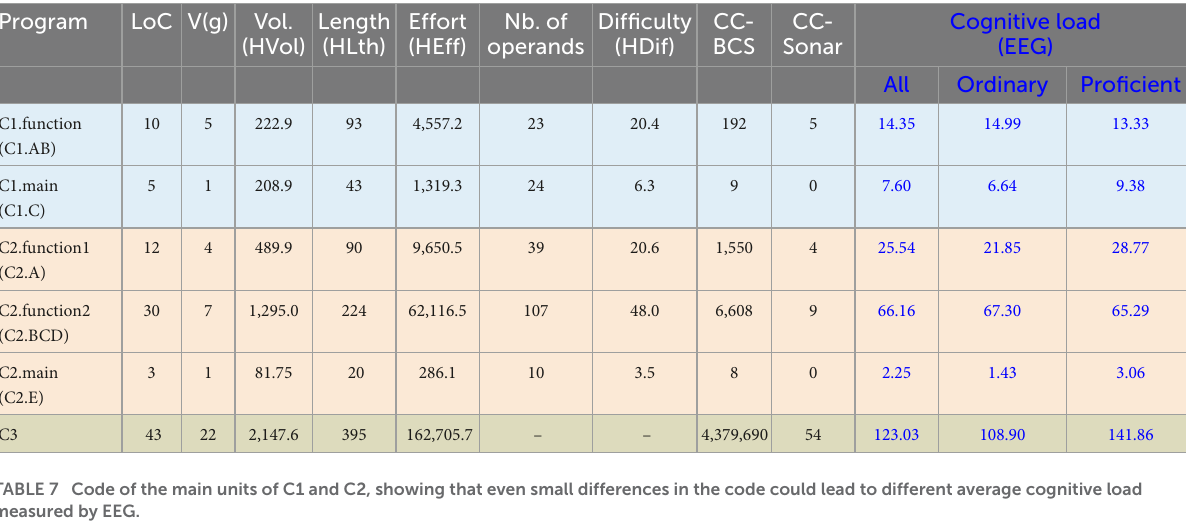
TABLE 6 Global results for all the code complexity metrics considered in the study. Program